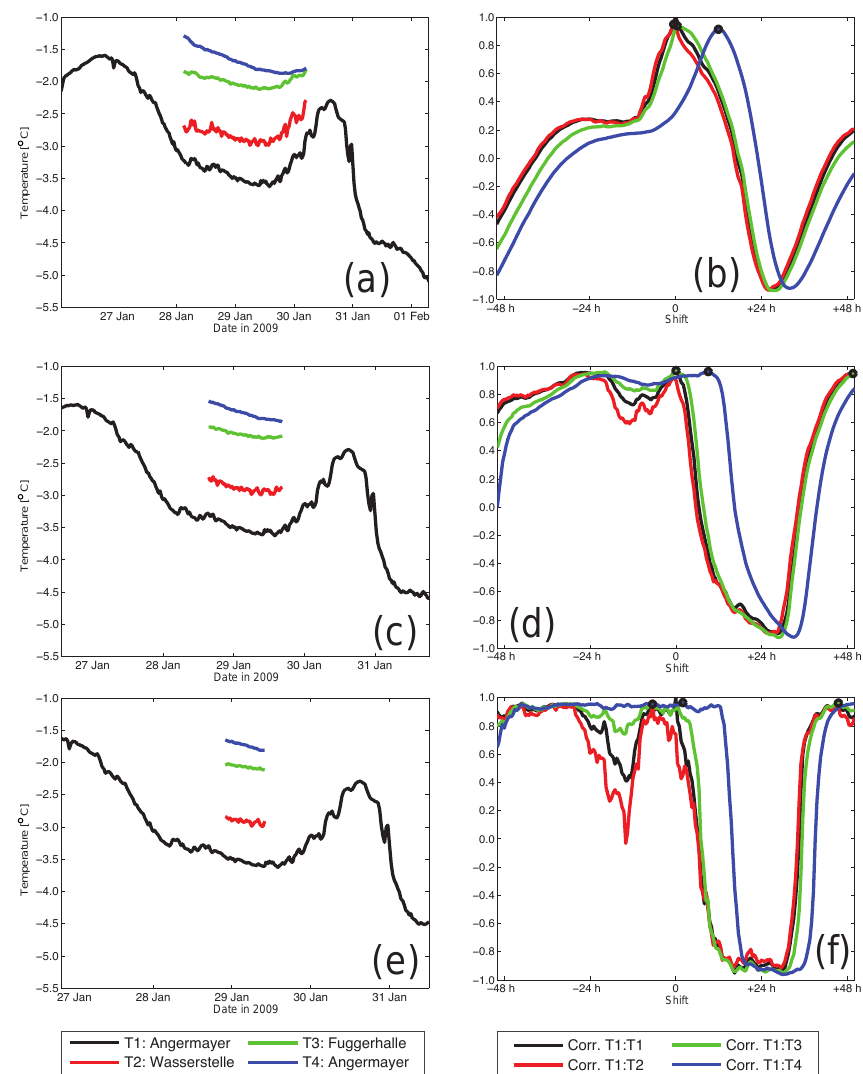
Figure 5. Observed temperatures (left panels) and correlation functions (right panels) during a period of small temperature variations, apparently not so well suited for correlation analysis. Data of loggers T2, T3, or T4 are cross-correlated with the data of logger T1 using a correlation length of 101 (a, b) , 51 (c, d) , and 25 (e, f)